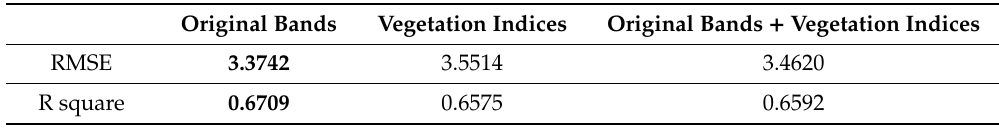
Table 3. Algorithm performance comparison based on five-fold cross-validation between different scenarios of random forest regression.